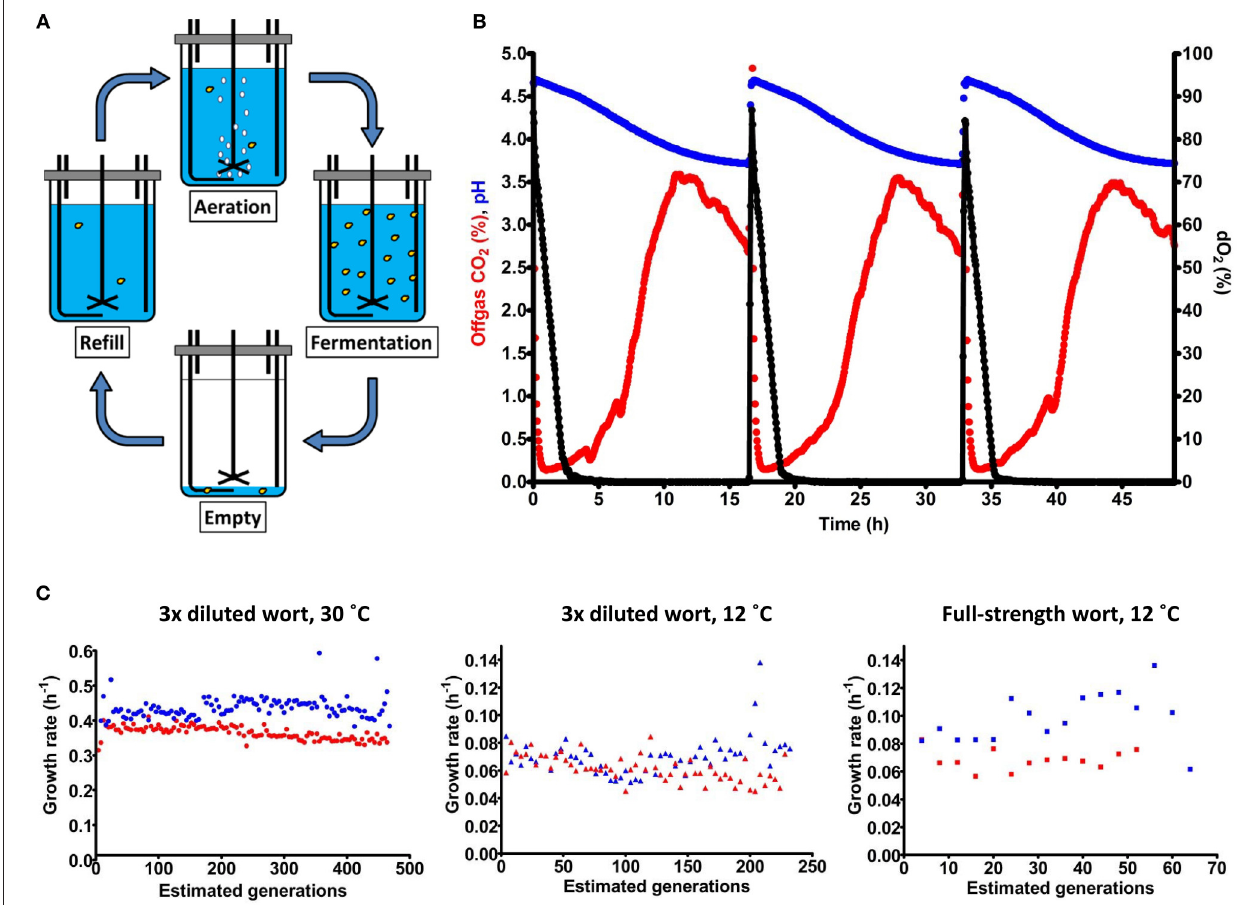
FIGURE 1 | Laboratory evolution mimicking the domestication of lager-brewing yeast. The S. cerevisiae x S. eubayanus laboratory hybrid IMS0408 was grown in duplicate sequential batch bioreactors in three-fold diluted wort at 30 ◦ C (LG30.1 and LG30.2) and at 12 ◦ C (LG12.1 and LG12.2), and in full-strength wort at 12 ◦ C (HG12.1 and HG12.2). (A) Experimental design for simulated sequential lager-beer brewing cycles. Each cycle consisted of four phases: (i) (re)filling of the fermenter with fresh medium up to a total volume of 100mL, (ii) aeration at 200 mL/min while stirring at 500 RPM, (iii) a batch fermentation phase without sparging or stirring, while flushing the bioreactor headspace with N 2 to enable accurate analysis of CO 2 production and (iv) removal of broth, leaving 7mL to inoculate the next cycle. (B) Fermentation profiles of three consecutive cycles from experiment LG30.1, performed at 30 ◦ C in three-fold diluted wort. Percentage of CO 2 in the off gas, culture pH and dissolved oxygen (dO 2 ) concentration are indicated by red, blue and black symbols, respectively. Due to the lack of stirring and sparging, CO 2 was slowly released by the medium; emptying of the reactor was initiated when the offgas CO 2 concentration dropped to 70% of its initial value as off-line analyses indicated that, at this point, all fermentable sugars had been consumed (C) Specific growth estimated from CO 2 production profiles during each cycle of the evolution lines. LG30.1 (blue circles) and LG30.2 (red circles) were grown on three-fold diluted wort at 30 ◦ C; LG12.1 (blue triangles) and LG12.2 (red triangles) were grown on three-fold diluted wort at 12 ◦ C. HG12.1 (blue squares) and HG12.2 (red squares) were evolved in full-strength wort at 12 ◦ C. Since lack of sparging and stirring precluded exact estimates of specific growth rates, the calculated values should be taken as